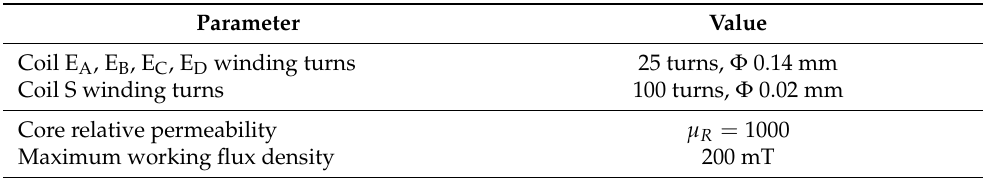
Table 1. Transducer parameters.